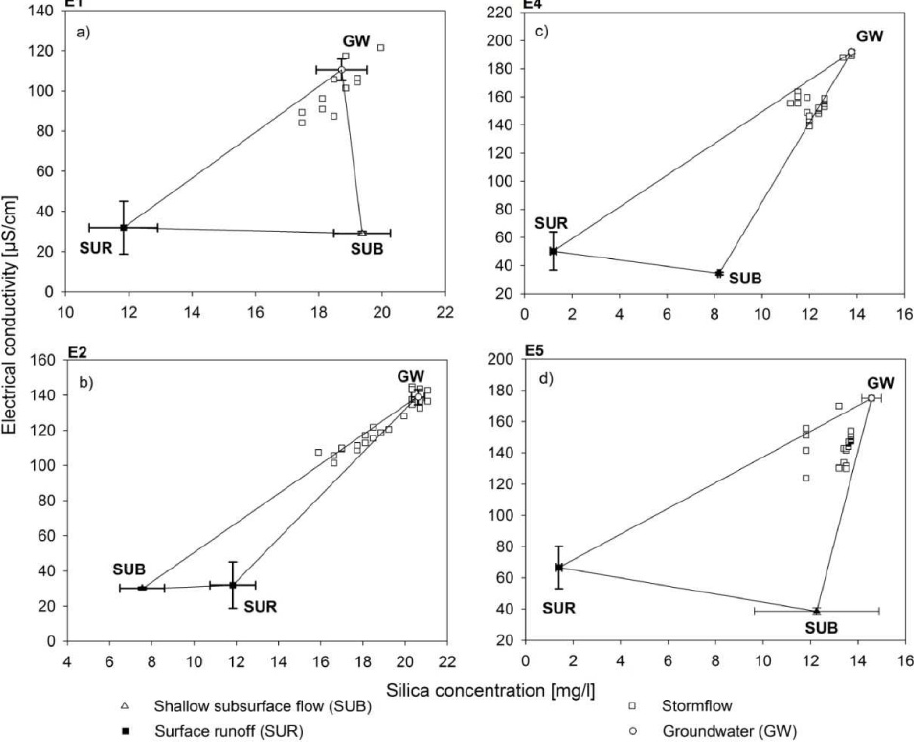
Fig. 7. Hydrochemical mixing diagrams for (a) 28 September 2007 (E1), (b) 9 October 2007 (E2), (c) 22 August 2009 (E4), and (d) 15 September 2009 (E5) based on endmembers of shallow subsurface flow (SUB), surface runoff (SUR) and groundwater (GW). Bars indicate standard deviations.